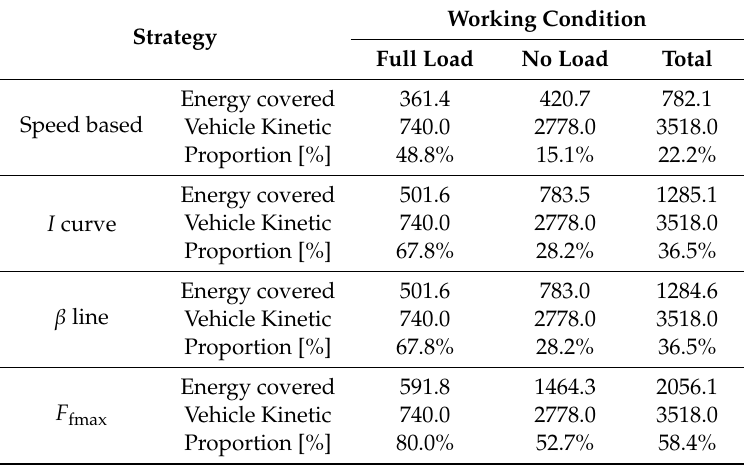
Table 3. Braking energy recovered of different braking strategies [kJ].